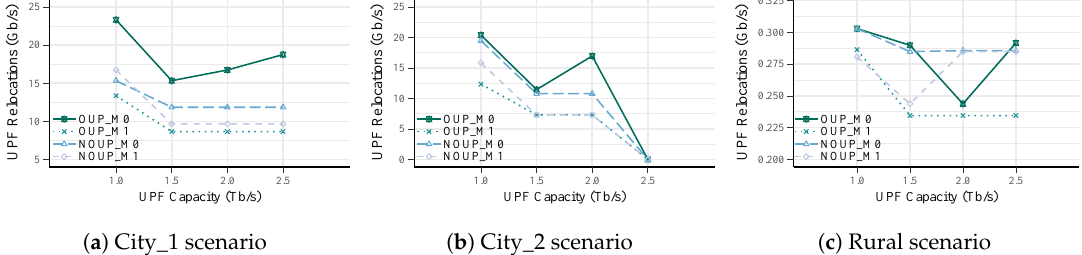
Figure 11. UPF Relocation Rate vs. capacity for services with high requirements.